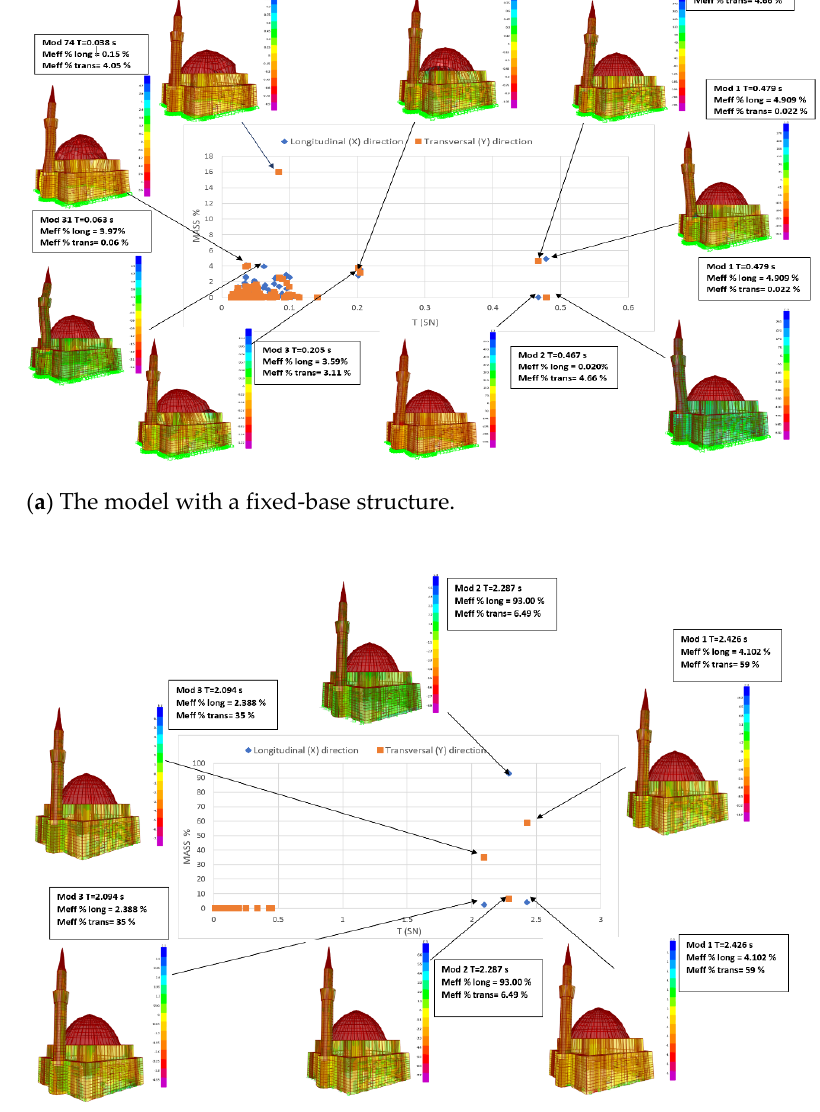
Figure 5. Distribution and stress of modal shapes in the longitudinal and transversal directions for the models with ( a ) a fixed-base structure and ( b ) base